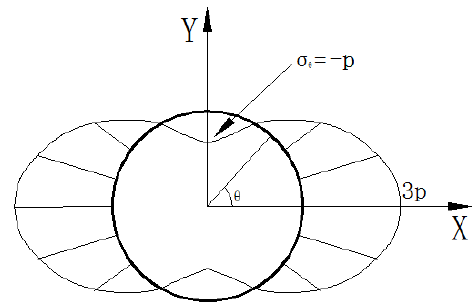
Figure 6. Stress distribution around the